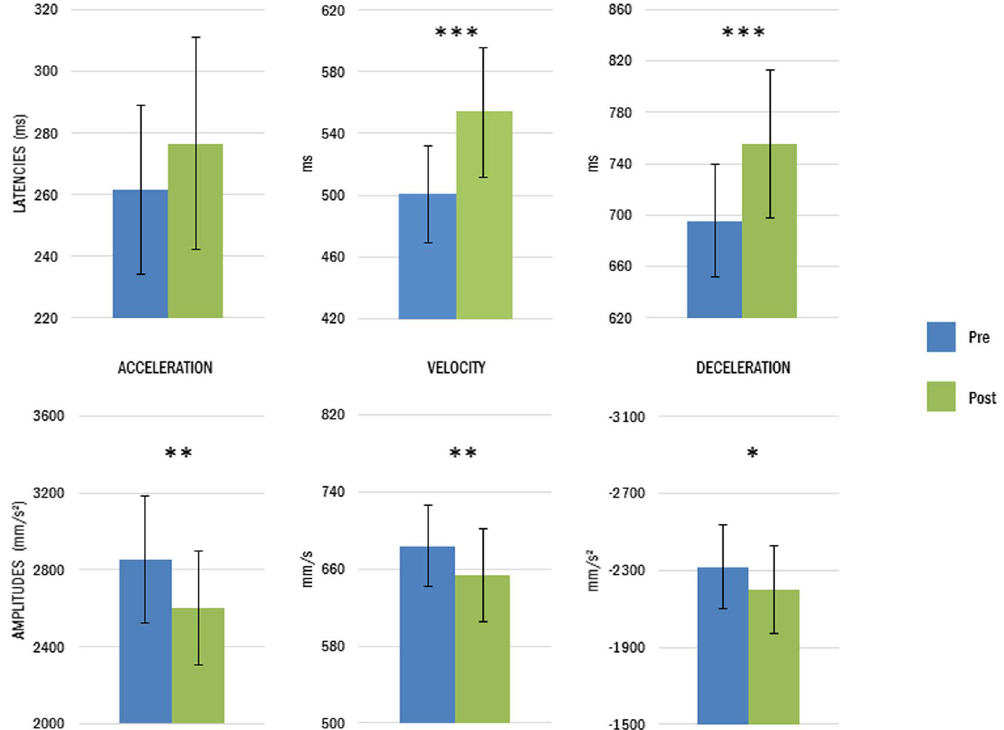
Figure 4. Tool use modifies movement kinematics of the reaching component. After tool use (green), participants (group average) showed longer latencies (upper graphs) and smaller peak amplitudes (lower graphs) compared to before tool use (blue). Asterisks denote significant differences between pre and